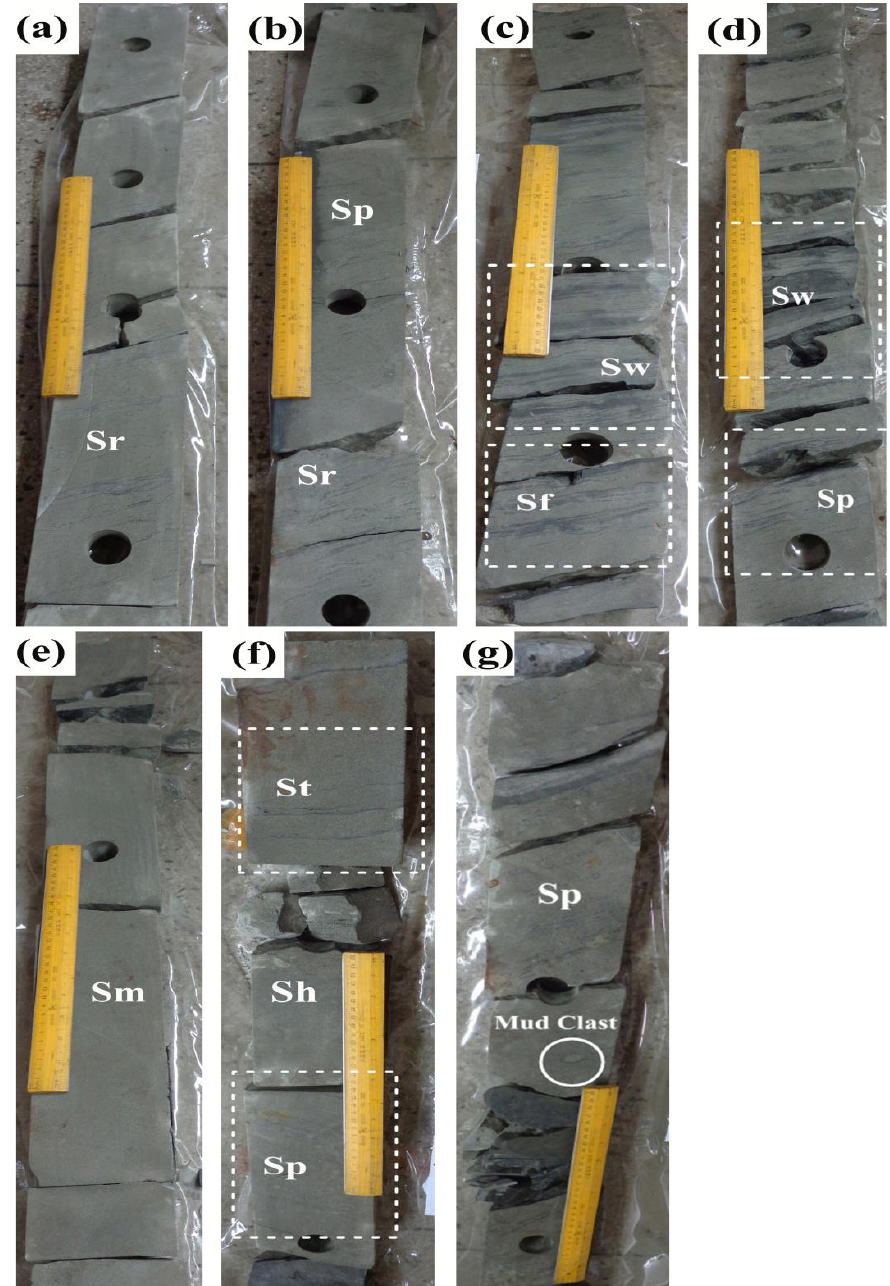
Figure 3. ( a ) Ripple cross-laminated sandstone (Sr) (3086 – 3087 m); ( b ) Planar cross-bedded sandstone (Sp) and ripple cross-laminated sandstone (Sr) (3087 – 3088 m); ( c) Wavy-bedded sandstone (Sw) and flaser-bedded sandstone (Sf) (3089 – 3090 m); ( d ) Wavy- bedded sandstone (Sw) and planar cross-bedded sandstones (Sp) (3090 – 3091 m); ( e ) Massive sandstone (Sm) (3091 – 3092 m); ( f ) Trough cross-bedded sandstone (St), Parallel bedded sandstone (Sh) and Planar cross-bedded sandstone (Sp) (3183 – 3184 m); ( g ) Planar cross-bedded sandstone (Sp) with mudclast (3184 – 3185 m). The principal facies of the fine grained facies association (FFA) include interbedded shale or claystone, shale with lenticular bedding, and sandstone or siltstone with shale [4].